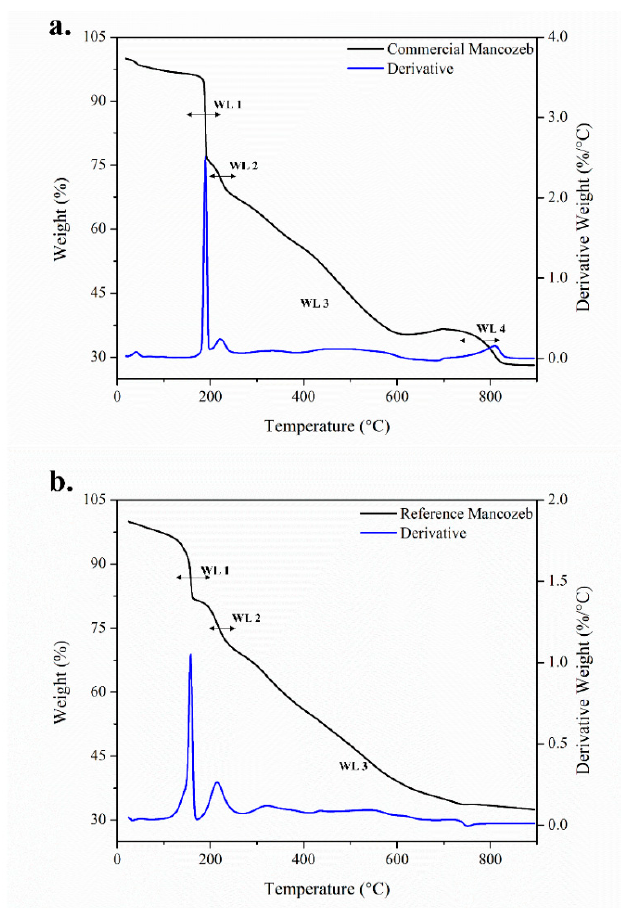
Figure 4. Thermograms for the mancozeb degradation profile: ( a ) Commercial presentation and ( b ) reference mancozeb.